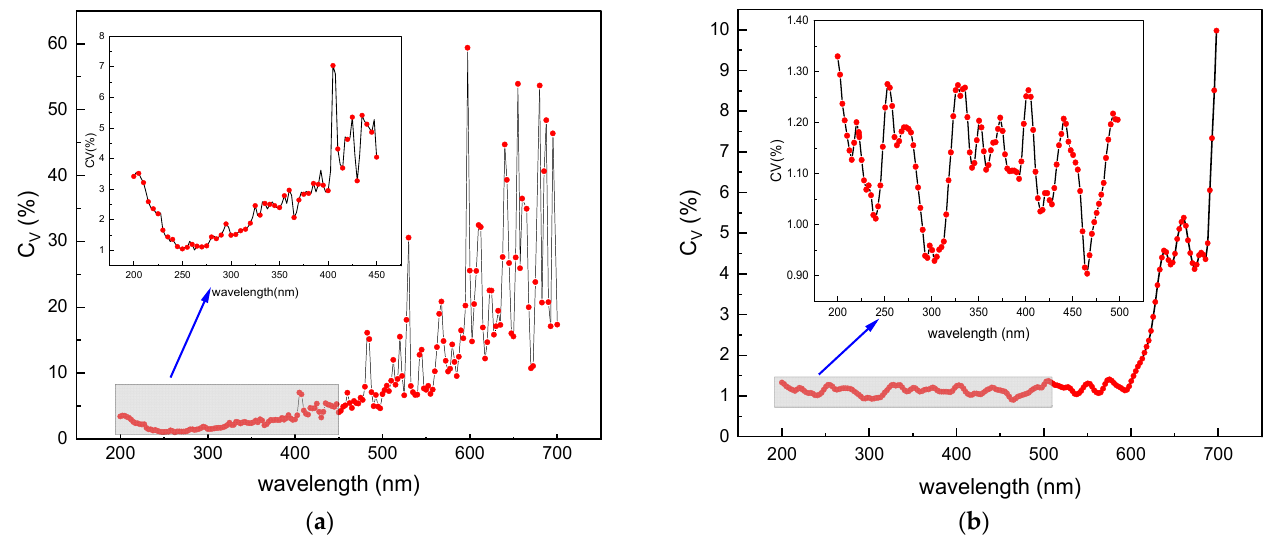
Figure 7. ( a ) Global coefficient of variation of the unfiltered data. ( b ) Global coefficient of variation of the filtered data.